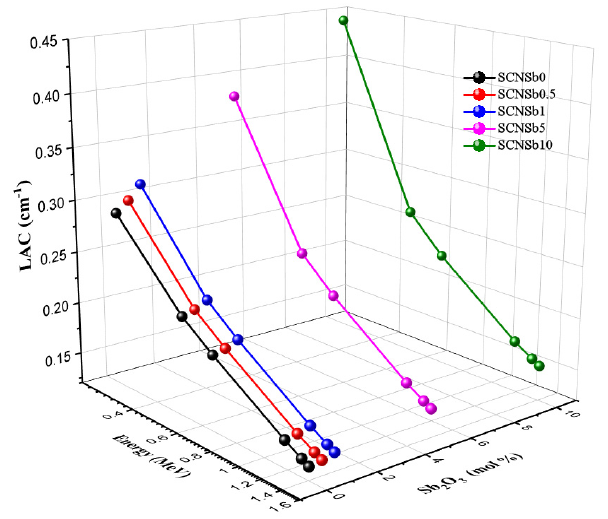
Figure 6. Variation of the linear attenuation coefficient LAC of the studied glasses versus the gamma photon energies and Sb 2 O 3 contents.